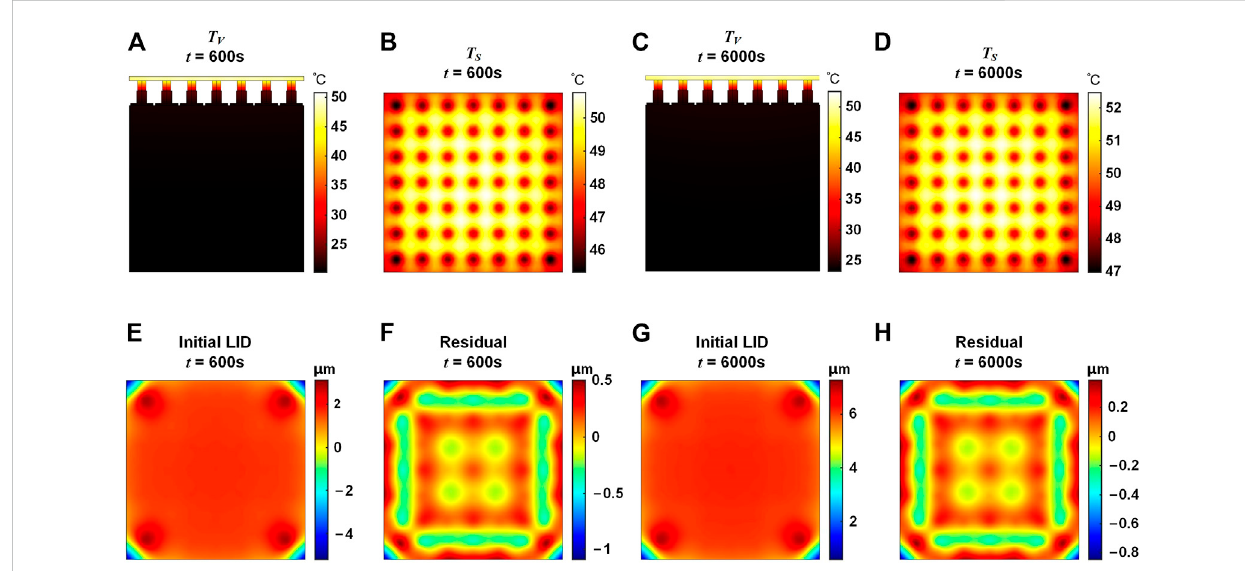
FIGURE 7 Temperature distribution and LID of the HDM under 600 s and 6000 s laser irradiation. (A) Overall temperature distribution T V , t = 600 s. (B) Mirror temperature distribution T S , t = 600 s (C) T V , t = 6000 s (D) T S , t = 6000 s. (E) Initial LID, t = 600 s. (F) Self-correction residual, t = 600 s. (G) Initial LID, t = 6000 s. (H) Self-correction residual, t = 6000